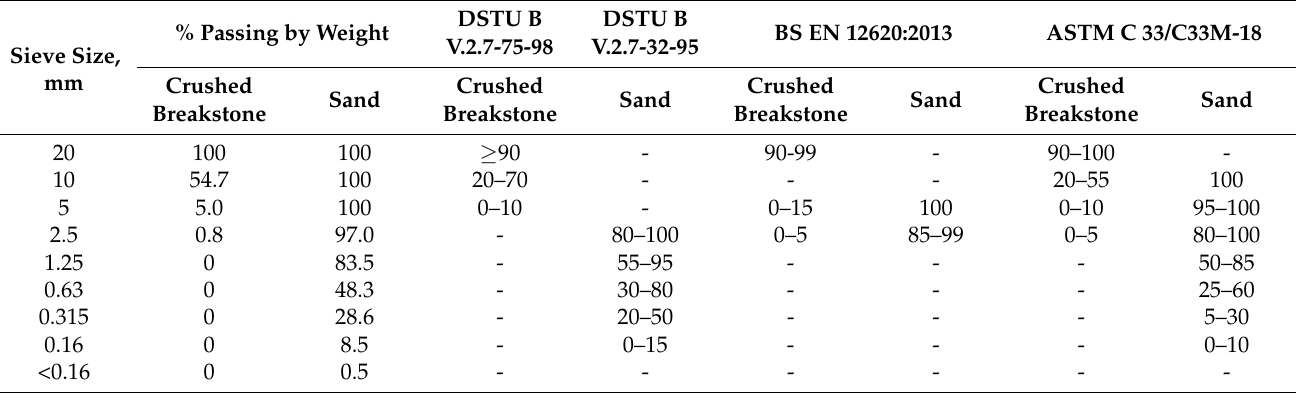
Table 2. Comparison of fine and coarse aggregates’ sieve analysis according to different building